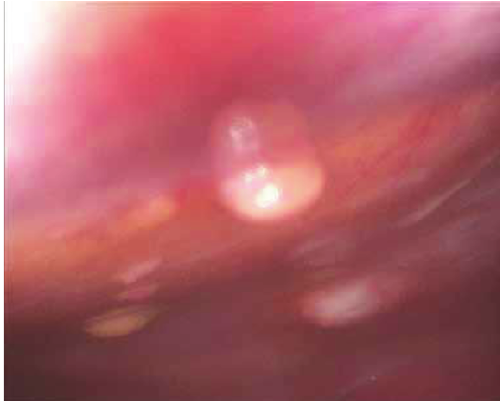
Figure 2: Laparoscopic image of glistening nodules on the peri- toneal surface.